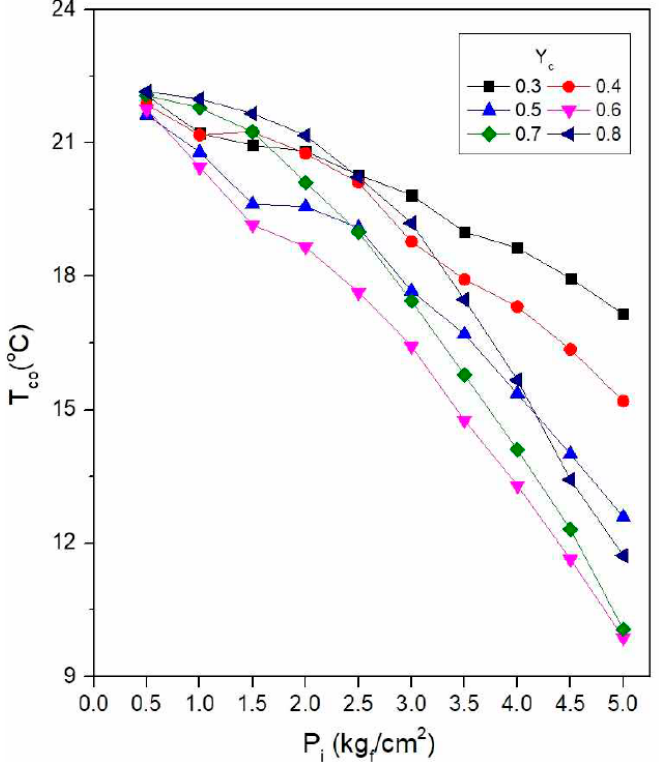
Figure 25. Direct heat exchange method of ∆ T co according to pressure.